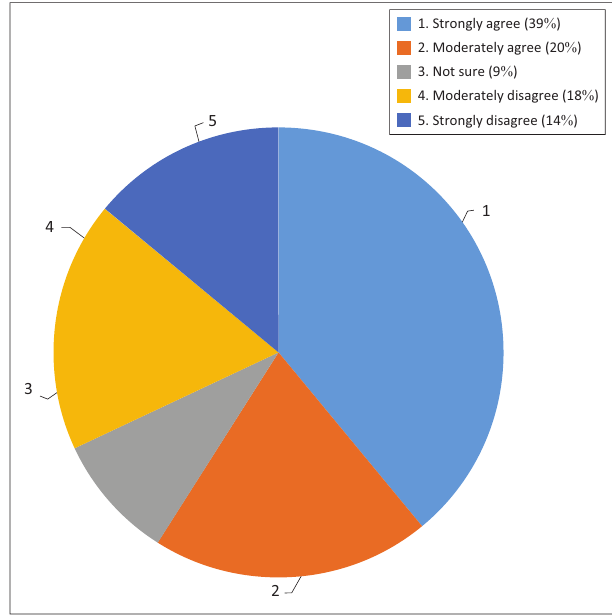
FIGURE 6 : Adaptation should be addressed purely in the context of other